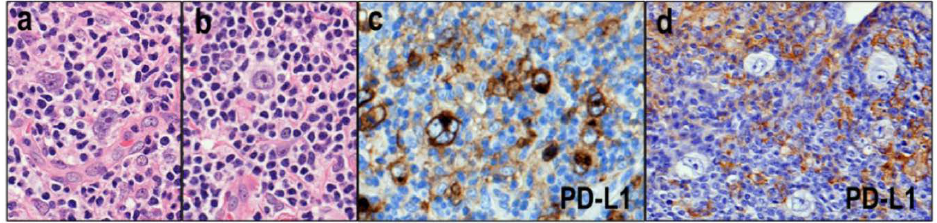
Figure 5. Follicular helper T-cell (TFH) lymphomas with Hodgkin-Reed-Sternberg (HRS)-like cells. ( a , b ) The immunoblasts in the background of TFH lymphomas occasionally mimic HRS cells (HE 400). ( c ) HRS cells show highly frequent PD-L1 expression ( × is rare in HRS-like cells ( ×